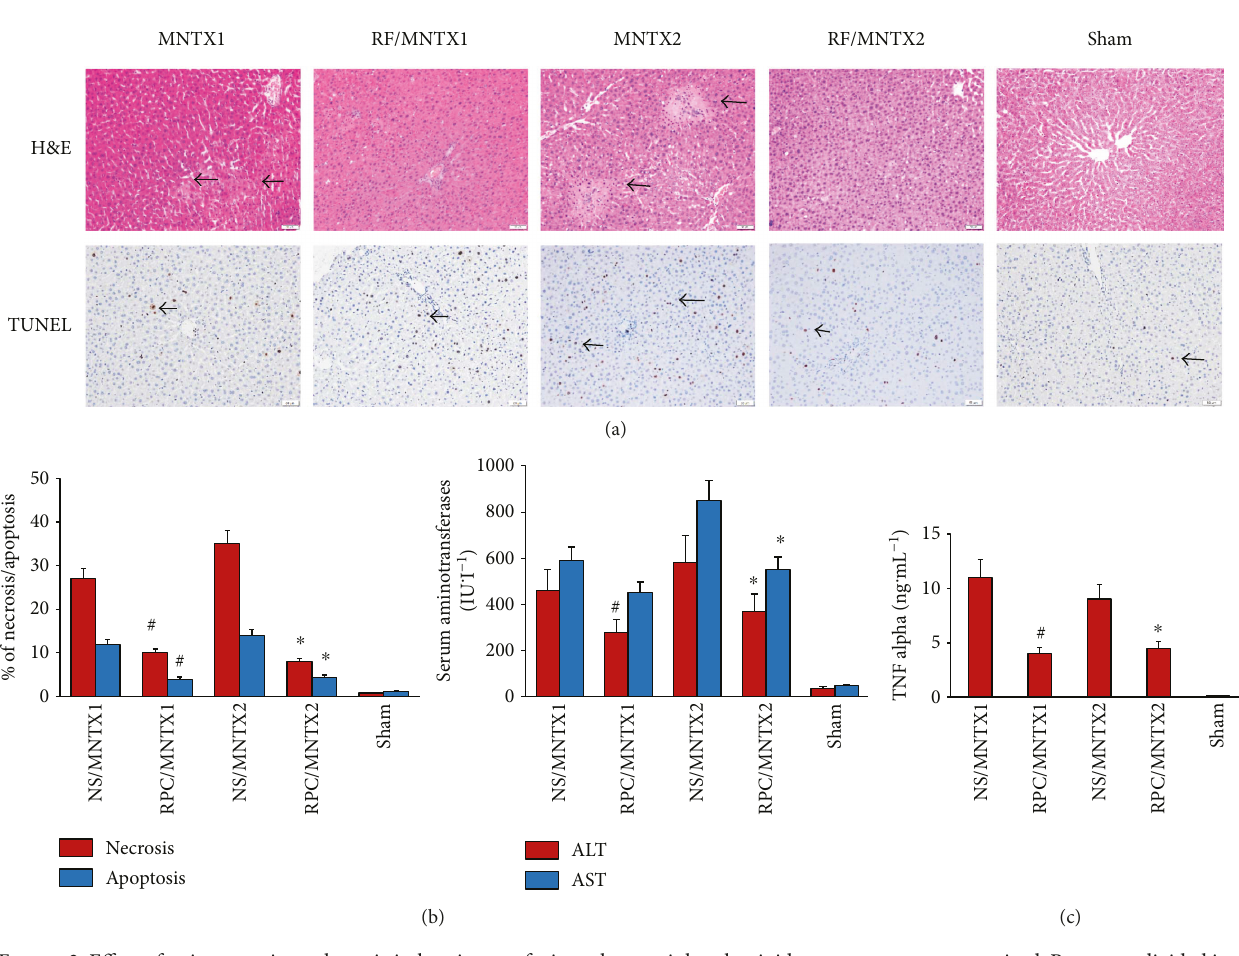
Figure 2: E ff ect of opiate agonist on hepatic ischemia reperfusion when peripheral opioid receptors were antagonized. Rats were divided into 5 groups, and animals were performed with laparotomy and dissection of the portal vein but not clamping in the sham group, or treated with MNTX1 (0.5mg · kg − 1 ) or MNTX2 (5 mg · kg − 1 ) into the peritoneal cavity, followed by an intravenous injection of 2 μ g · kg − 1 · min − 1 of remifentanil or normal saline within 15 minutes. Hepatic ischemia reperfusion (IR) was induced 10 minutes after the treatment above with ischemia for 45 minutes and 120-minute reperfusion. n = 8 in each treatment group and n = 5 in the sham group. (a) Hepatic tissue histologic changes were processed with hematoxylin and eosin (H&E) staining for light microscopy examination. Photograph depicts a typical pattern of focal necrosis (black arrows) after ischemic degeneration of hepatocytes around the central venous area. Hepatocyte apoptosis was determined by TUNEL staining. Photograph depicts a typical pattern of apoptotic cells (black arrows). Areas of necrosis and percentage of apoptotic cells were signi fi cantly decreased in the remifentanil preconditioning (RPC) groups than in the normal saline (NS) groups (magni fi cation: 200x; # P < 0 05 versus NS/MNTX1; ∗ P < 0 05 versus NS/MNTX2). (b) Serum alanine aminotransferase (ALT) was signi fi cantly lower in the RPC/MNTX1 groups than in the NS/MNTX1 groups, while serum alanine aminotransferase (ALT) and aspartate aminotransferase (AST) concentrations were signi fi cantly lower in the RPC/MNTX2 groups than in the NS/MNTX2 groups ( # P < 0 05 versus NS/MNTX1; ∗ P < 0 05 versus NS/MNTX2). (c) The serum level of TNF- α signi fi cantly decreased in the remifentanil preconditioning (RPC) groups than in the NS groups ( # P < 0 05 versus NS/MNTX1; ∗ P < 0 05 versus